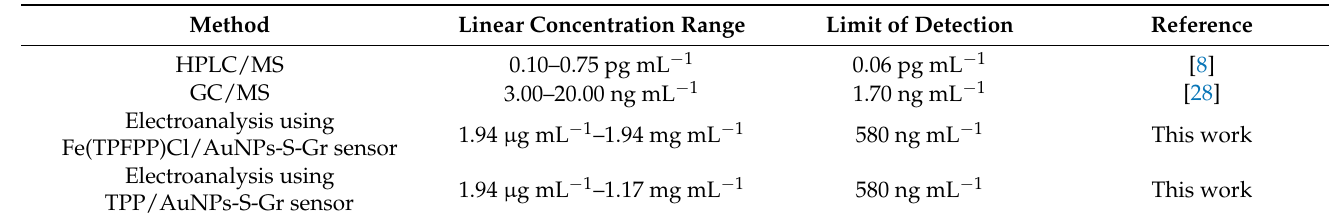
Table 4. Comparison between performances of chromatographic methods and the proposed electro- chemical method.